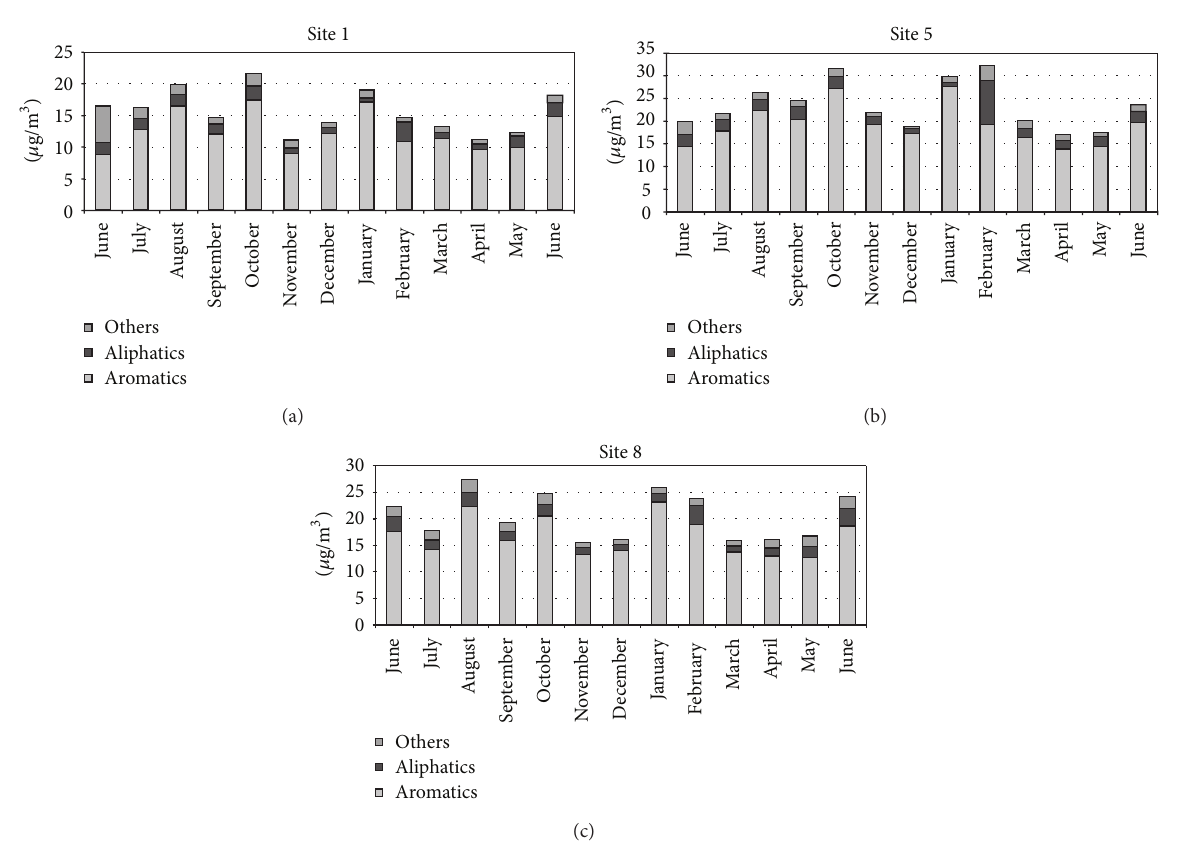
Figure 3: Trend of VOCSum, differentiated among aromatics aliphatics and other compounds, in the most polluted sites.